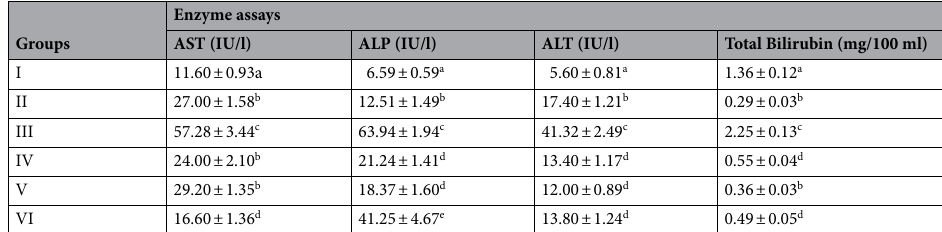
Table 8. Effect of P. americana extracts on the liver enzymes of alloxan-diabetic rats. Values represent mean ± standard deviation (n = 5). Values with different superscripts (a,b,c,d,e) along the same column are significantly different from one another (P < 0.05). Group I—normal control rats, Group II—diabetic rats treated with glibenclamide, Group III—diabetic rats not treated, Group IV—diabetic rats treated with methanol extract of P. americana stem bark, Group V—diabetic rats treated with methanol extract of P. americana leaves, Group VI—diabetic rats treated with methanol extract of P. americana root.